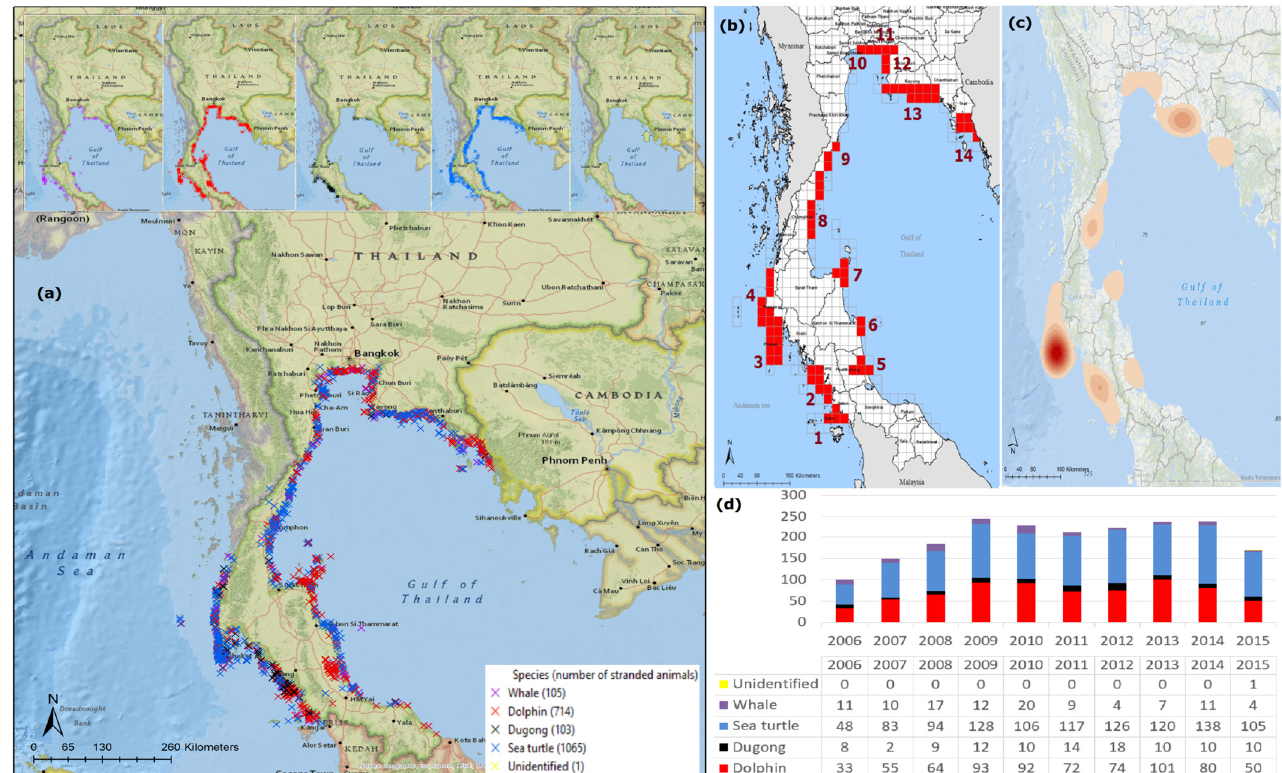
Figure 1. ( a ) Map of Thailand showing the locations of endangered marine species stranded in Thailand from 2006 to 2015; ( b ) Hot spots (red squares) of animal stranding according to cluster analysis. Significant clusters ( p < 0.01) were detected in the following 14 provinces: (1) Satun, (2) Trang, (3) Phuket, (4) Phang Nga, (5) Phatthalung, (6) Nakhon Si Thammarat, (7) Surat Thani, (8) Chumphon, (9) Prachuap Khiri Khun, (10) Samut Sakhon, (11) Samut Prakan, (12) Chonburi, (13) Rayong, and (14) Trat; ( c ) Density of stranded animals from high (red colour) to low (orange colour) according to Kernel density analysis; ( d ) Number of stranded animals per year by species.